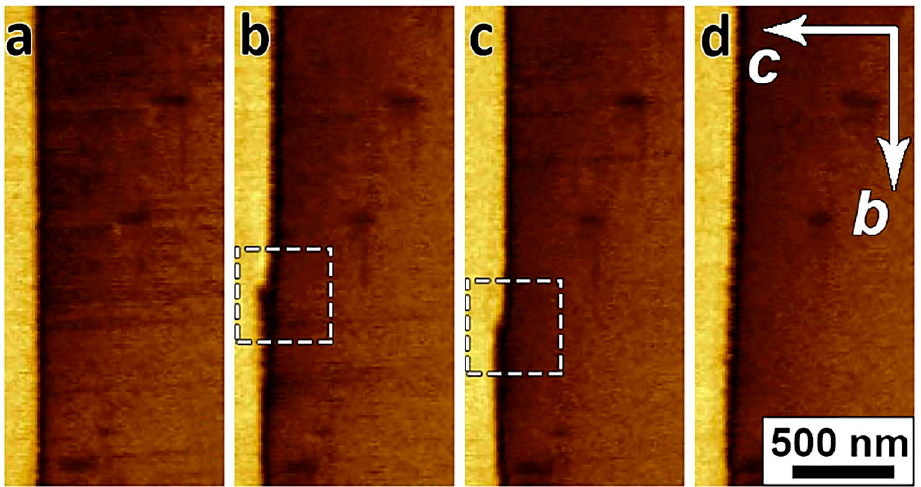
Figure 13. PFM images of the macrostep motion along the neutral domain wall: ( a ) 0, ( b ) 10, ( c ) 30, and ( d ) 50 min since the start of measurement. Arrows b and c show the direction of crystal axis.